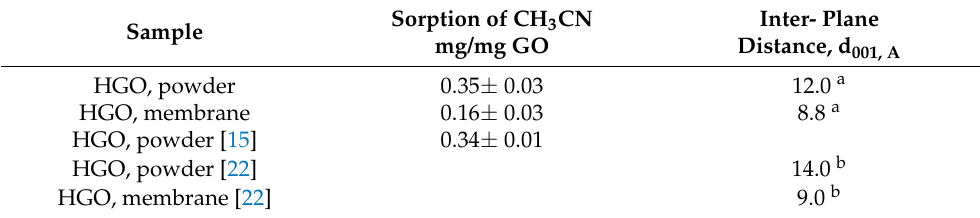
Table 4. Swelling of HGO materials in CH3CN at T = 298